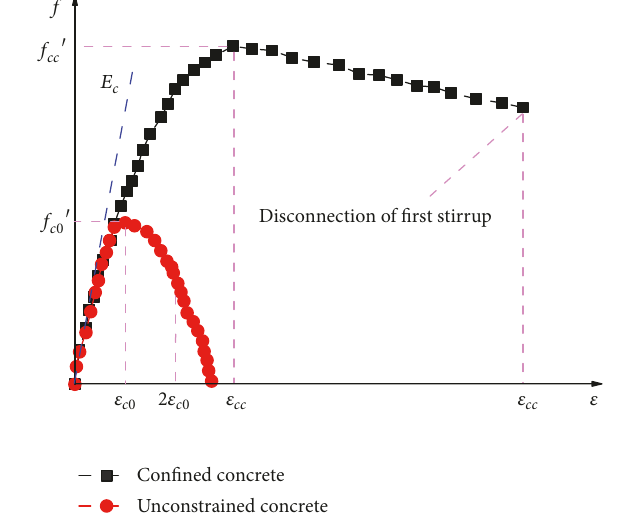
Figure 3: Stress-strain relationship.